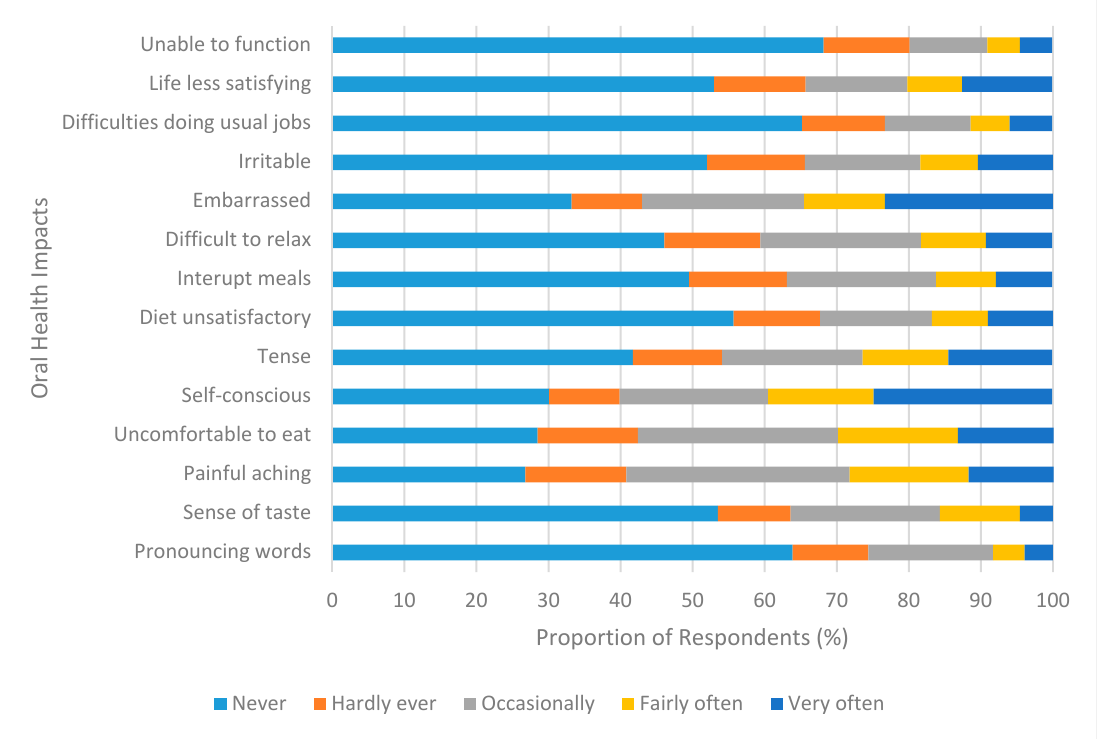
Figure 2. Frequency of oral health impacts.